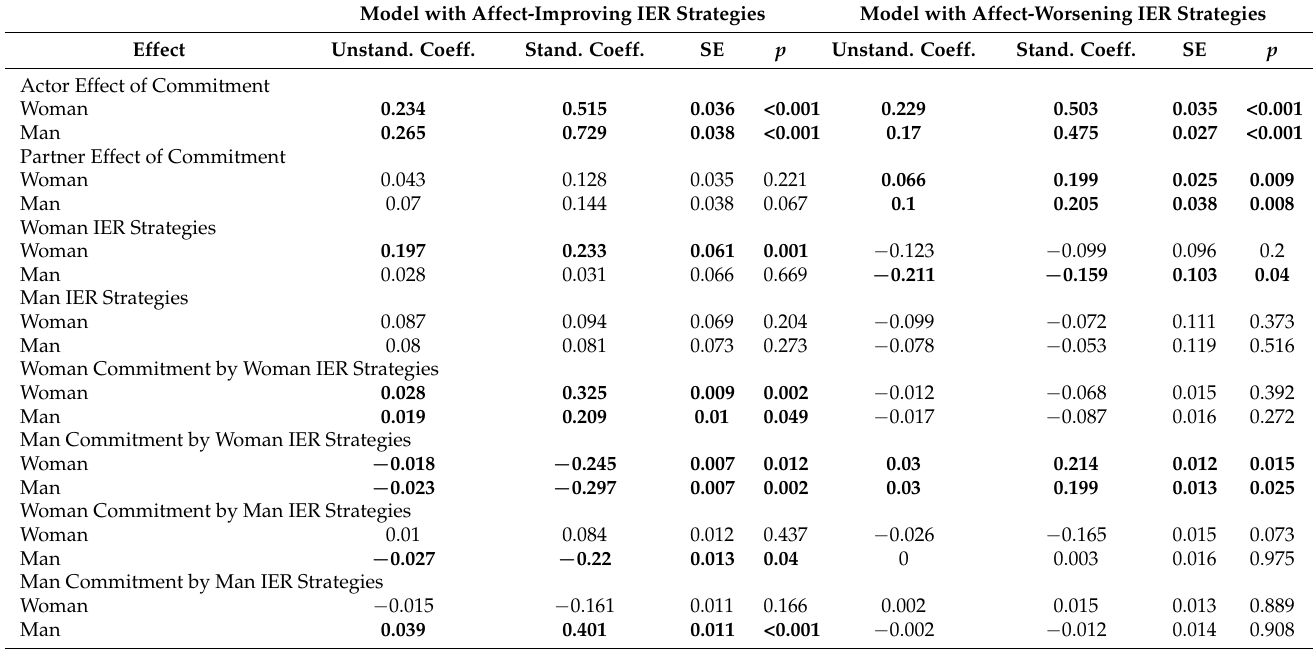
Table 3. Model predicting couple satisfaction from commitment, moderated by women’s and men’s interpersonal affect-improving and affect-worsening strategies. Model with Affect-Improving IER Strategies Model with Affect-Worsening IER Strategies Effect Unstand. Coeff. Stand. Coeff. SE p Unstand. Coeff. Stand. Coeff. SE